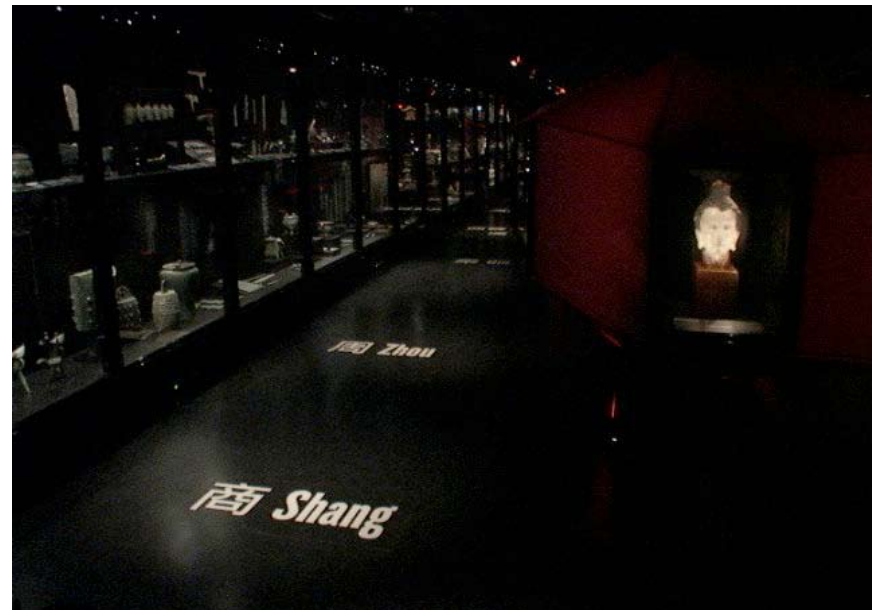
Fig 2. The Middle Kingdom, part of the view from the